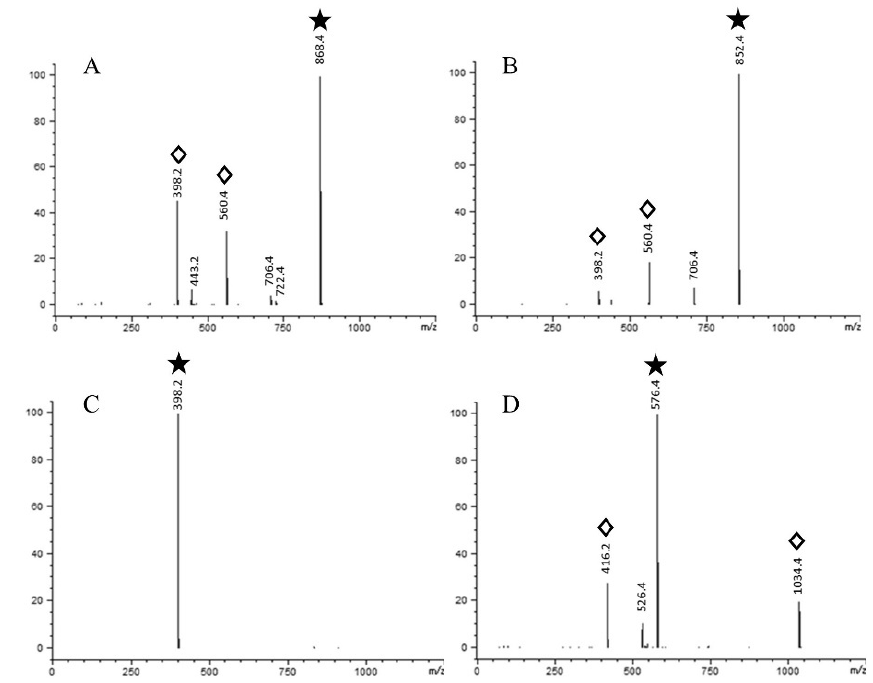
Figure 2. Mass spectrometric spectra of the standard solutions of α -solanine ( A ), α -chaconine ( B ), solanidine ( C ), and tomatine ( D ) at 10 µg mL − 1 in scan mode. Fragment masses are shown above peaks. Diamonds above masses are ions used for target ( ) and qualifier ions in single ion monitoring mode ( ).